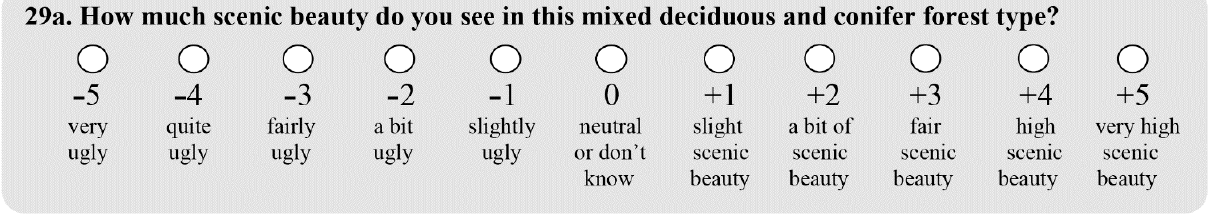
Figure 2. Example survey page where respondents identify and rate scenic beauty for a forest type.